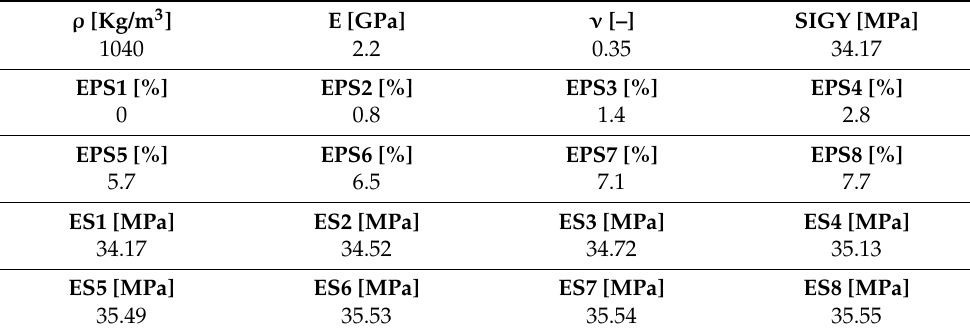
Table 4. Acrylonitrile Butadiene Styrene (ABS) material data [25].